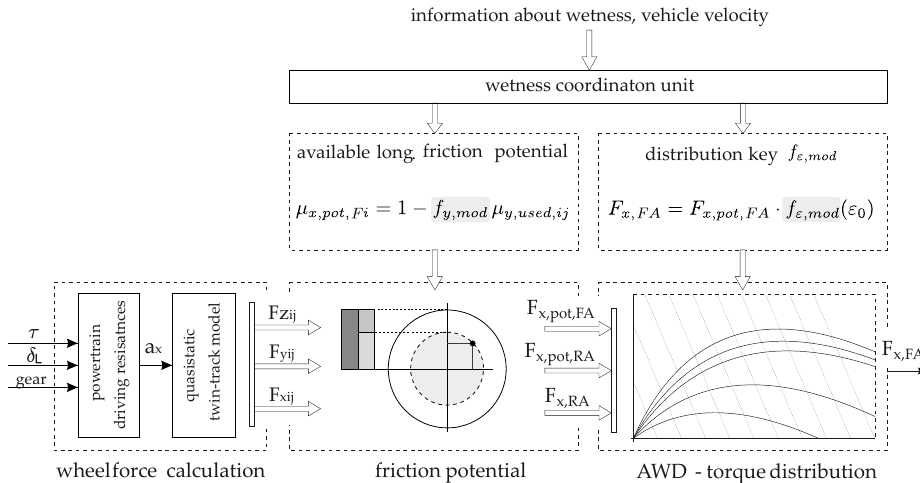
Figure 4. Overview of the overall concept of the extended all-wheel-drive control with superordinate wetness coordination unit. Newly created parameters allow a specific calibration for